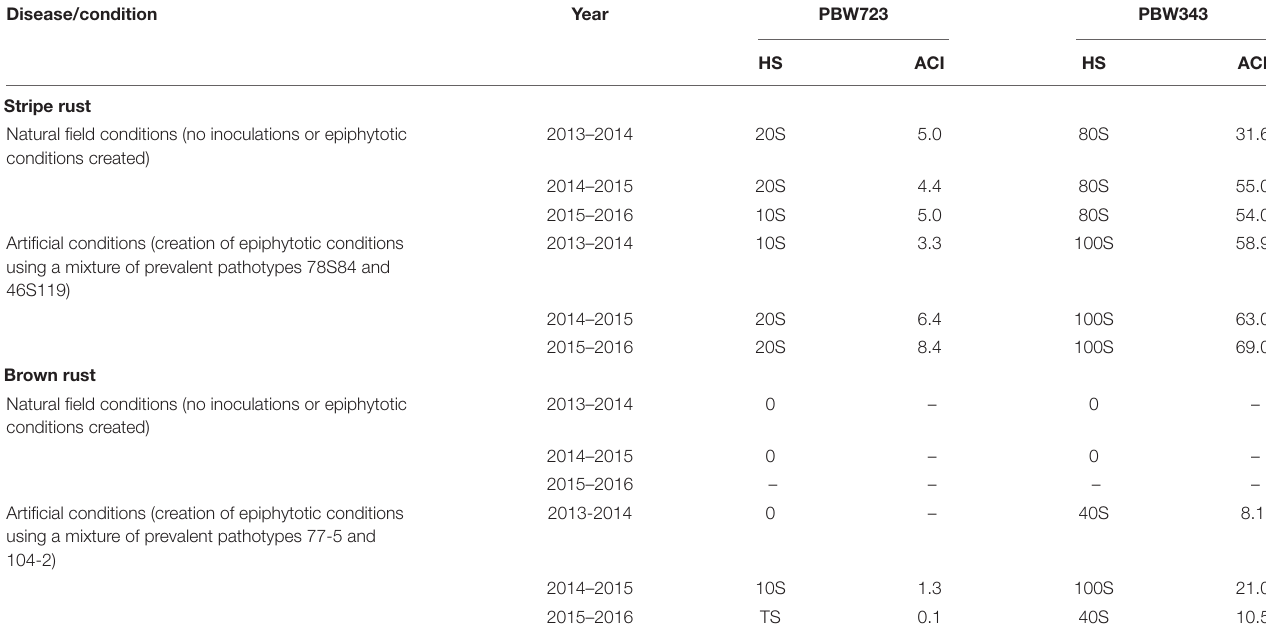
TABLE 6 | Reaction of PBW723 to stripe and leaf rust under natural and artificial conditions at seedling and adult plant stage from 2013–2014 to 2015–2016. Disease/condition